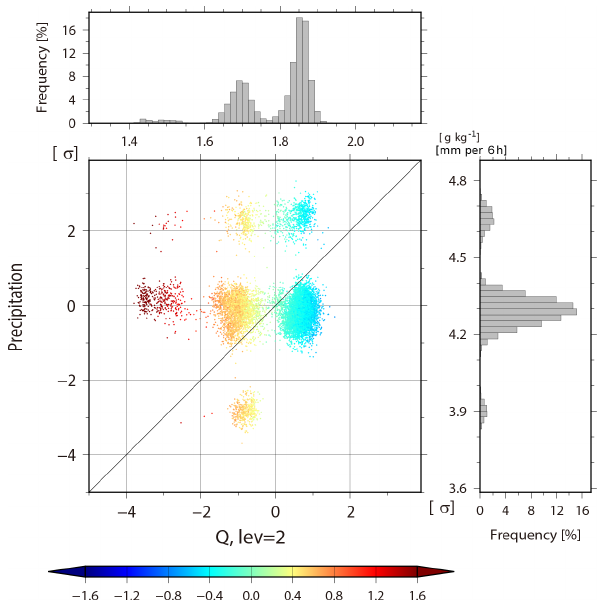
Figure 15. Scatter diagram of background specific humidity at the second model level ( ∼ 850hPa) versus background precipita- tion at 42.7 ◦ N, 48.8 ◦ W (311.3 ◦ E) at 06:00UTC on 15 Febru- ary. The colors show d θ (cid:48) e = ( d θ e 06 : 00UTC − d θ e 00 : 00UTC ) − (cid:1) The histograms in the right and up- (cid:0) d θ − d θ e 06 : 00UTC e 00 : 00UTC per panels show background precipitation and temperature at the same grid point, respectively.